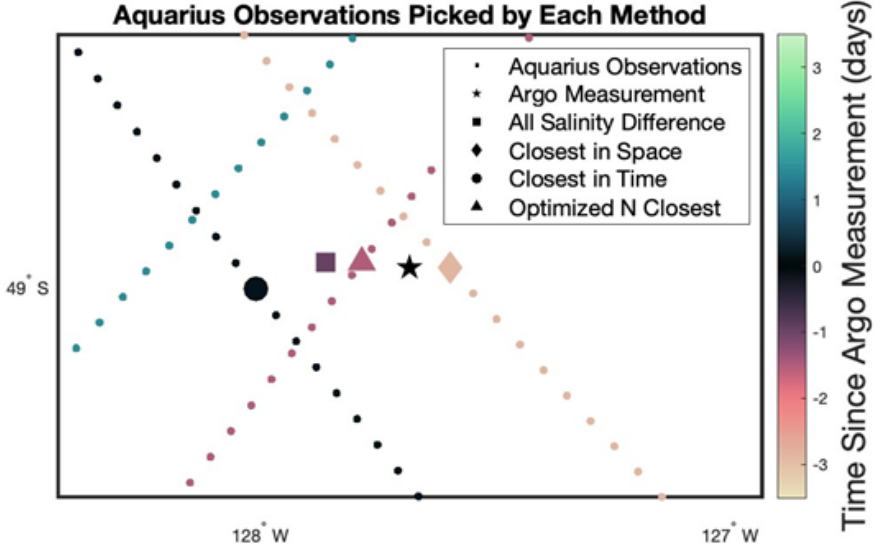
Figure 2. Aquarius satellite observations picked by each method for comparison with a typical Argo measurement ( ) in the PAC region (See Figure 1 and Table 1). The square ( ◾ ) symbol shows the ★ average location of the points used in the ASD method. The triangle ( ▲ ) symbol shows the average location of the points used in the NCLO method, which has been optimized for this region. The diamond ( ♦ ) symbol shows the closest observation in space to the Argo measurement, which is used for the SSDS method. The circle (●) symbol shows the observation that is the closest in space to the Argo measurement out of the group of observations that are closest in time, which is used for the SSDT method. The symbol color shows how many days before or after the Argo measurement the Aquarius observations or average of several Aquarius observations occurred, with color scale at right. Each method below only considers the satellite observations made within 50 km and ±3.5 days of the Argo measurement. This window is recommended in ref. [22].